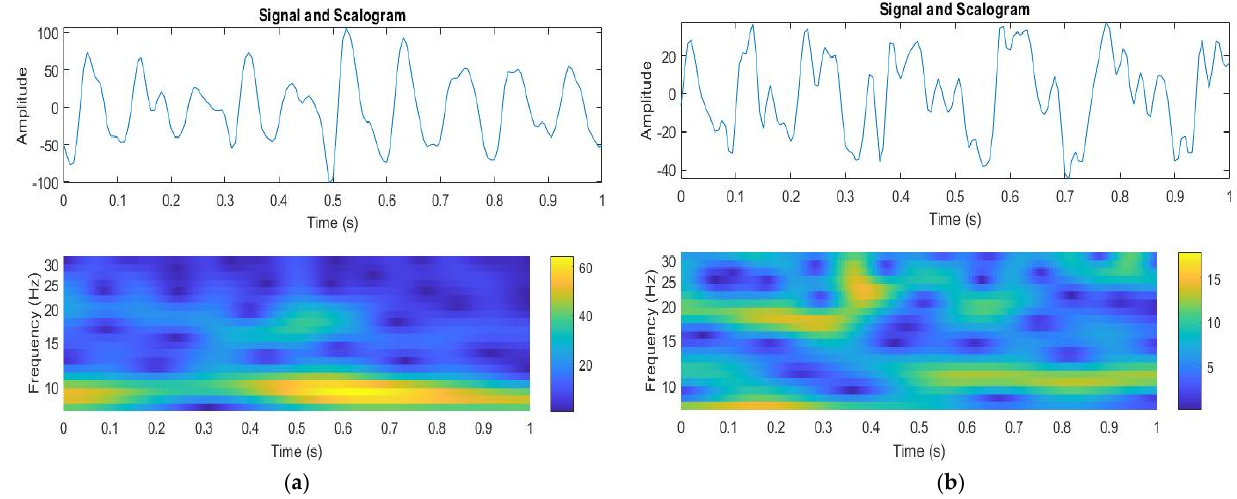
Figure 5. Time-frequency signal analysis diagram. ( a ) shows the 8–30 Hz filter signal when the eyes are closed while plots the original signal in the upper subplot and the CWT scalogram in the lower subplot, and ( b ) shows the 8–30 Hz filter signal when the eyes are open.